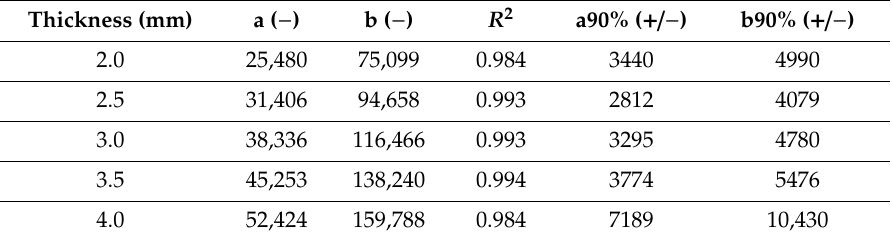
Table 3. Values of the parameters of ETMEA